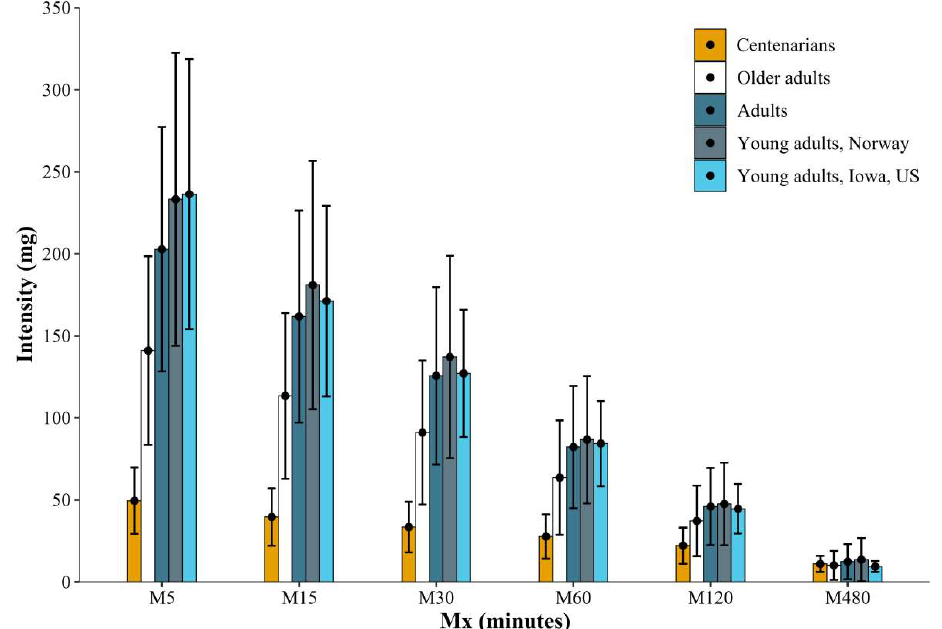
Figure 2. Mx metrics during the lifespan. Mx metrics = acceleration above which a person’s most active X minutes are accumulated (i.e., M120 refers to the intensity at which the most active 120 min of the day were spent). Young adults, Adults and Older adults are normative data from Norway by HS Rosfjord in the University of Adger: “New metrics for analysis and presentation of device-based indices of physical activity” [35]; and Young adults from US are data from Rowlands et al. [36]. Note that physical activity in [35,36] was measured using ActiGraph GT3X+ accelerometers worn at the hip.